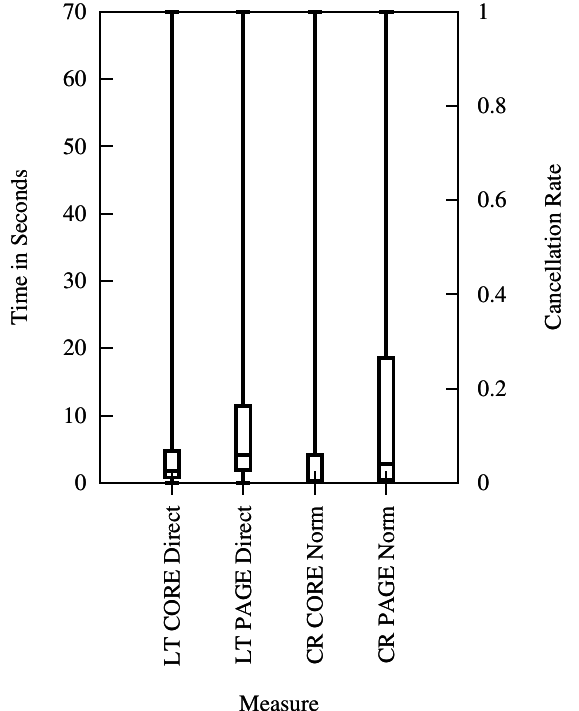
Figure 12. Latency and Cancelation Rate for Normal Web Browsing (Survey